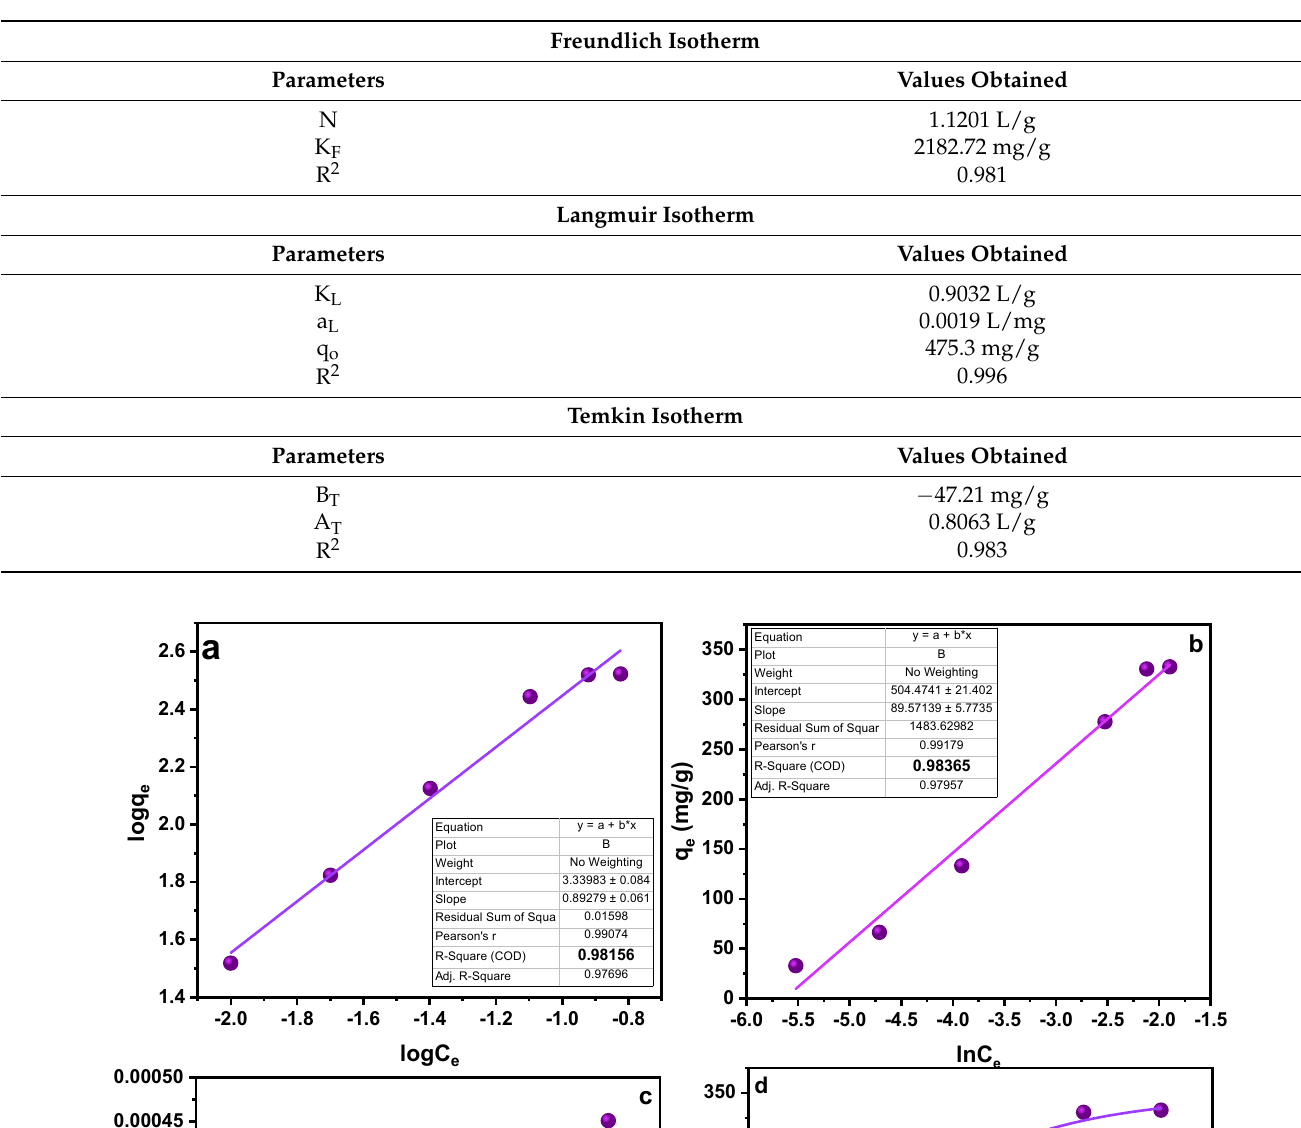
Table 2. Isotherm parameters for Freundlich isotherm, Langmuir isotherm, and Temkin isotherm.